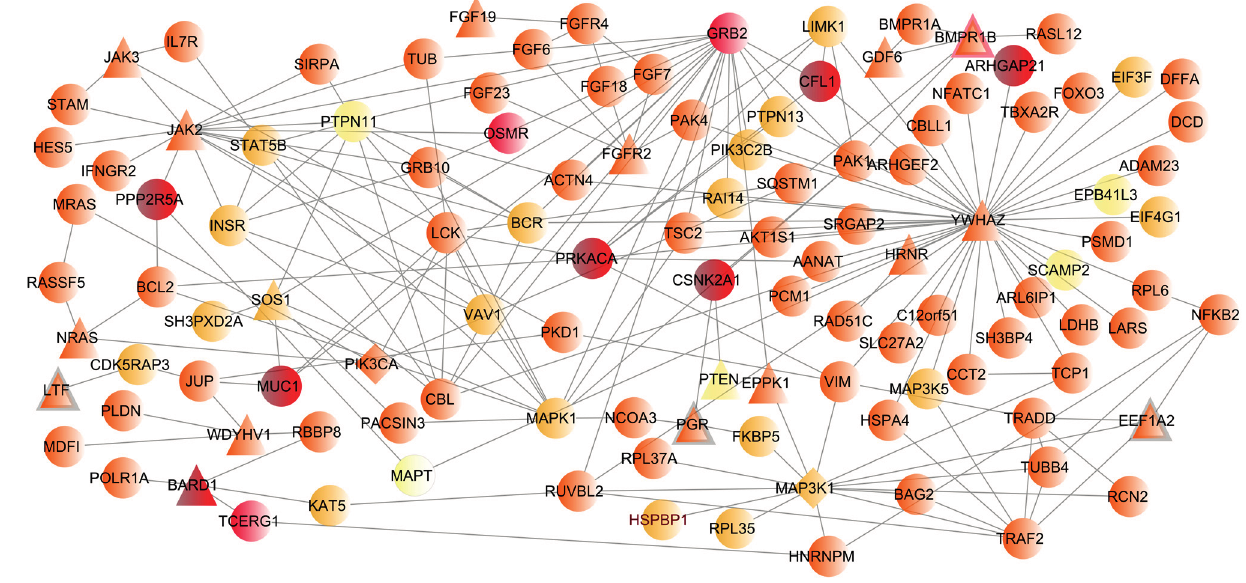
Figure 4. Breast cancer network. This network illustrates the 19 known breast cancer genes included in the breast cancer LCC and their first neighbors. Nodes are colored based on a score reflecting their presence in an additional LCC cancer dataset (neuroblastoma) and in the LCCs for the four unrelated diseases. A darker color represents a higher score, which means a higher specificity for cancer. The shape of the node reflects the presence of each gene in breast cancer gene lists (genes associated with breast cancer in NextBio, genes with somatic mutations, copy number abnormalities or differential expression obtained from COSMIC database and TCGA data portal). Circular nodes are proteins absent from the four lists, triangular nodes are proteins present in one and diamond nodes in two. A thicker border indicates that the gene was reported to be differentially expressed in breast